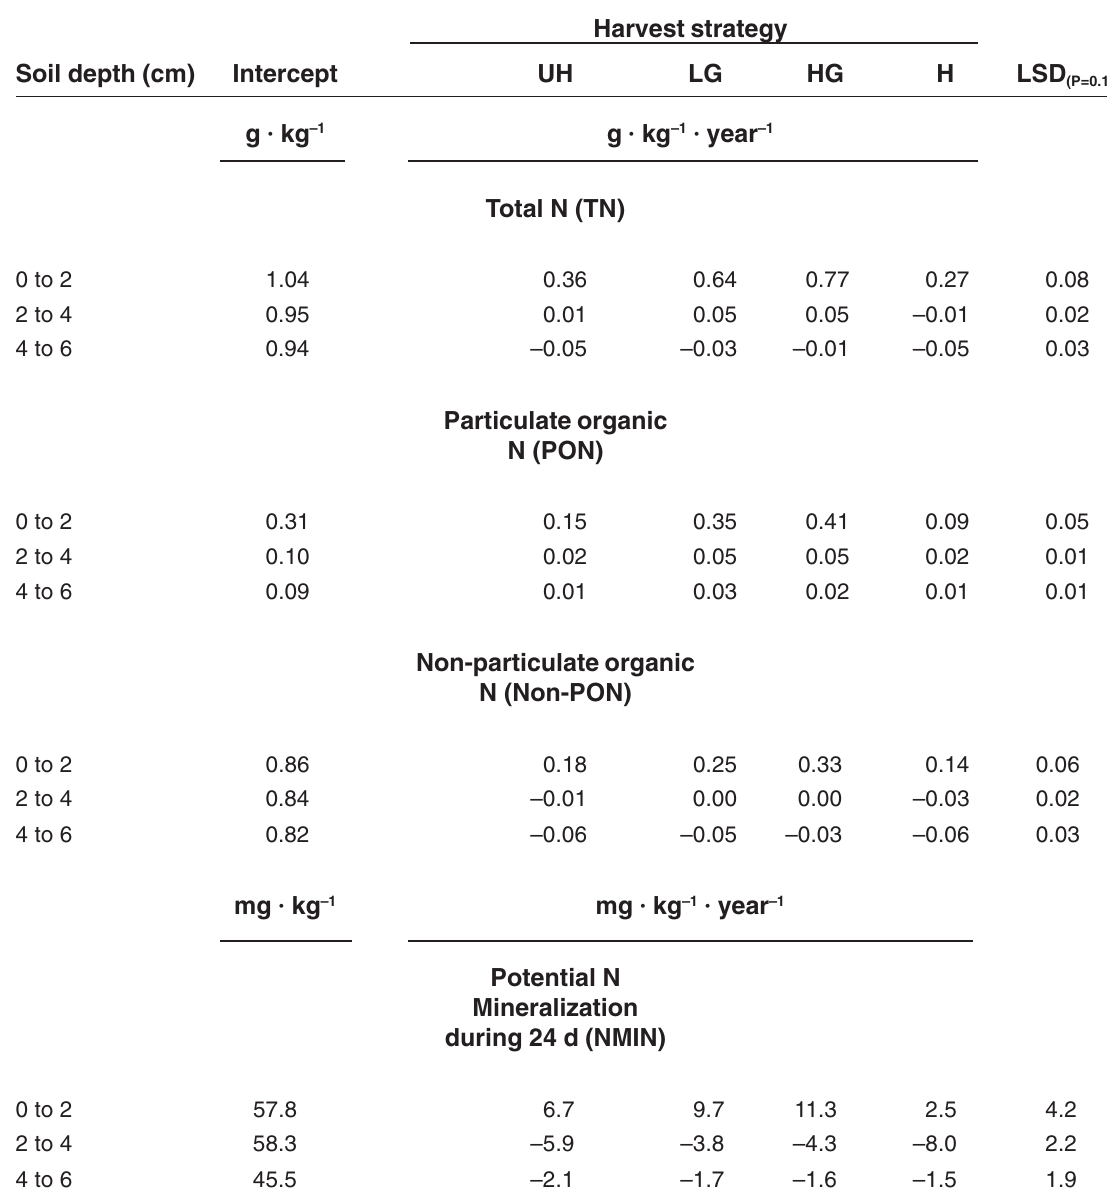
Rate of Change in N Pools, Based on Linear Regression, During the First 4 Years of Management as a Function of Soil Depth and in Response to Harvest Strategy Averaged across Fertilization